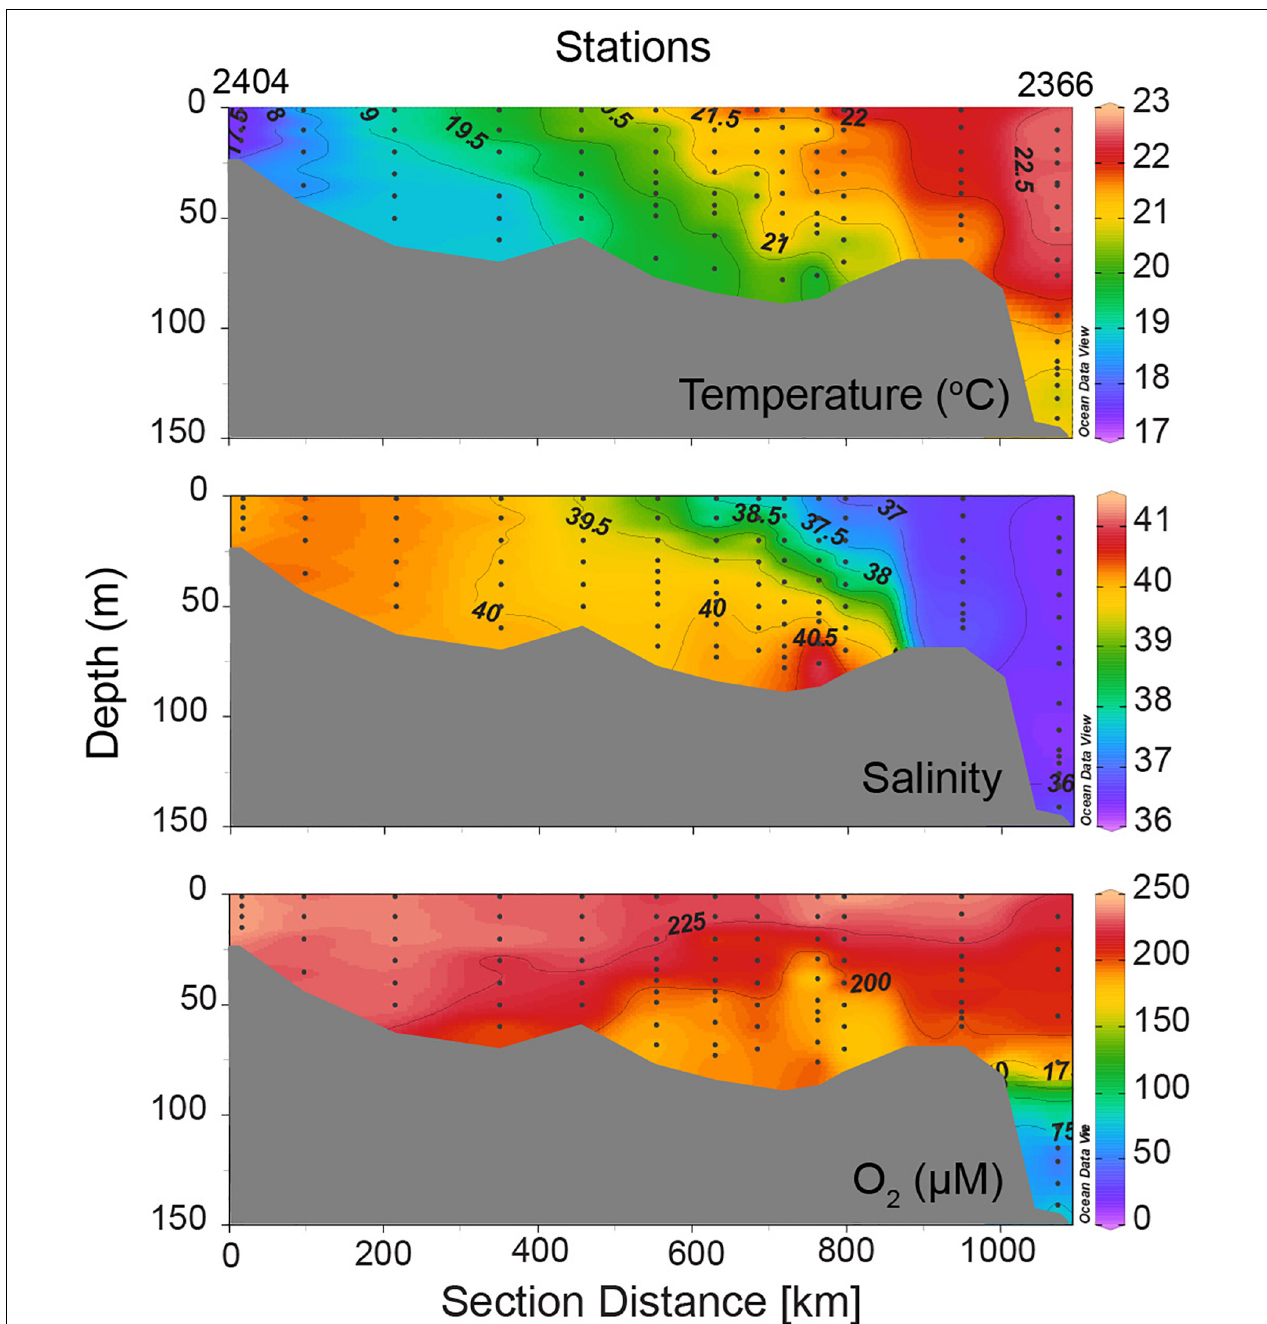
FIGURE 4 | Vertical sections of temperature, salinity, and dissolved oxygen along the main axis of the Persian Sea constructed using data collected during the R.V. Atlantis II cruise in February 1977 (Brewer et al., 1978). Salinity and oxygen sections are redrawn from Brewer and Dyrssen (1985).